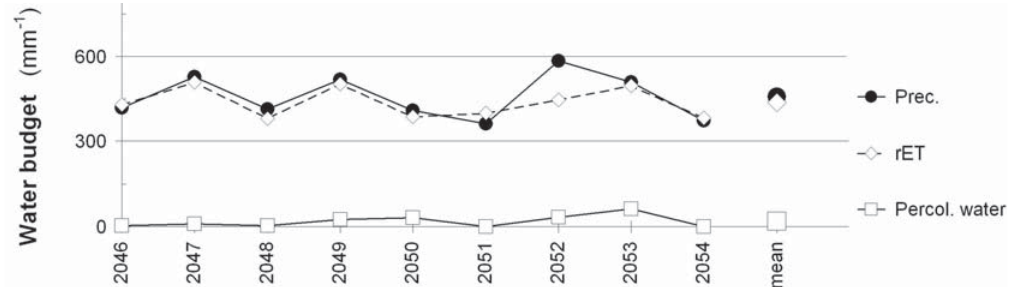
Figure 9. Time series of the simulated water budget of Scenario 2050. (Prec. = precipitation, rET = real evapotranspiration).